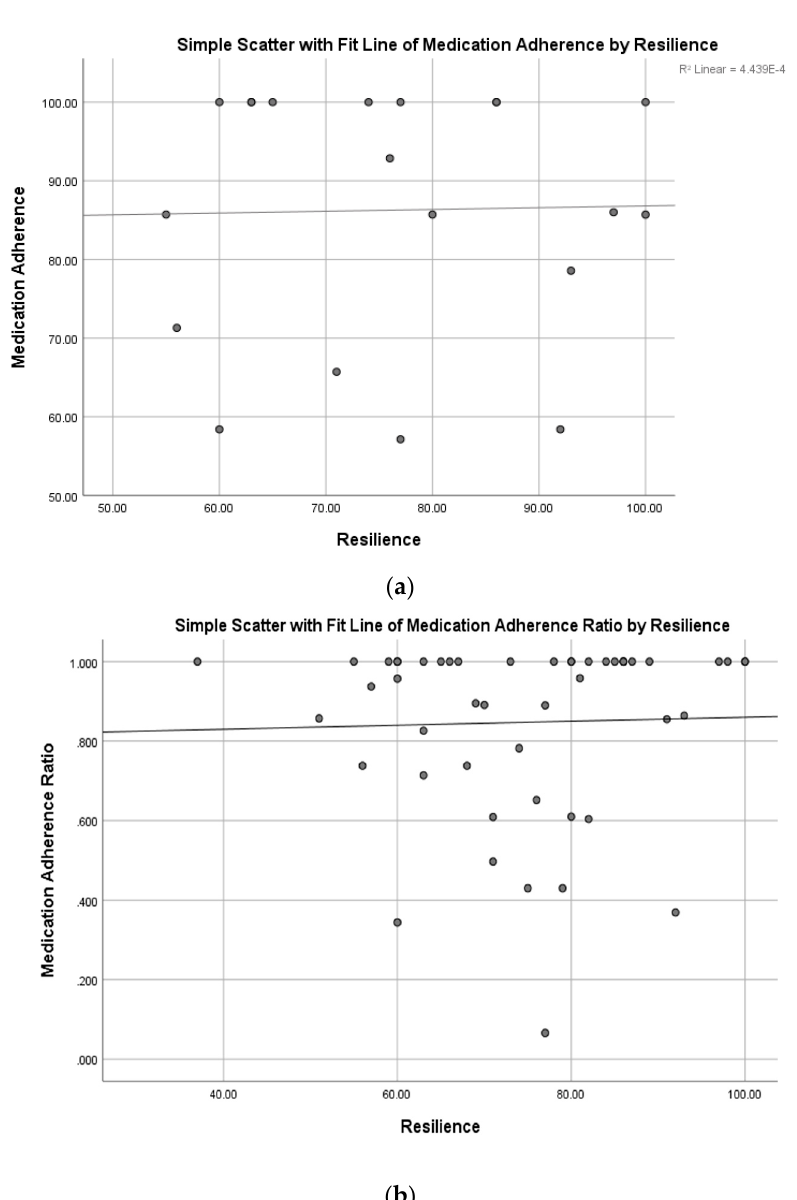
Figure 2. ( a ) Relationship between resilience and self-reported medication adherence. ( b ) Relationship between resilience and medication adherence ratios.